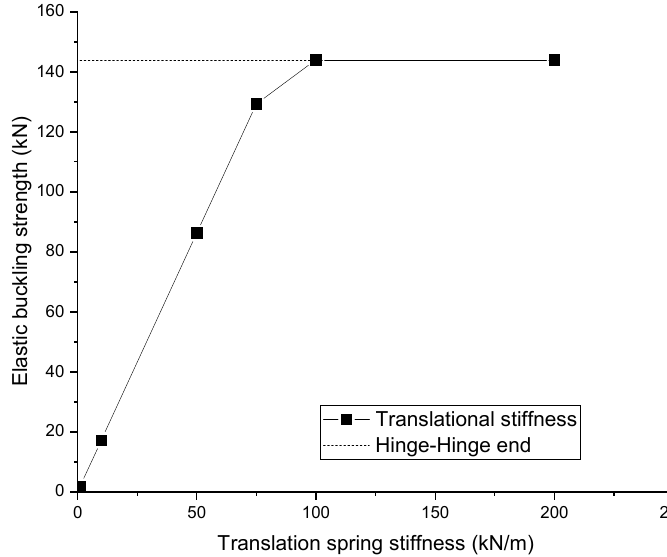
Figure 11. Buckling strength curve according to the translational stiffness.